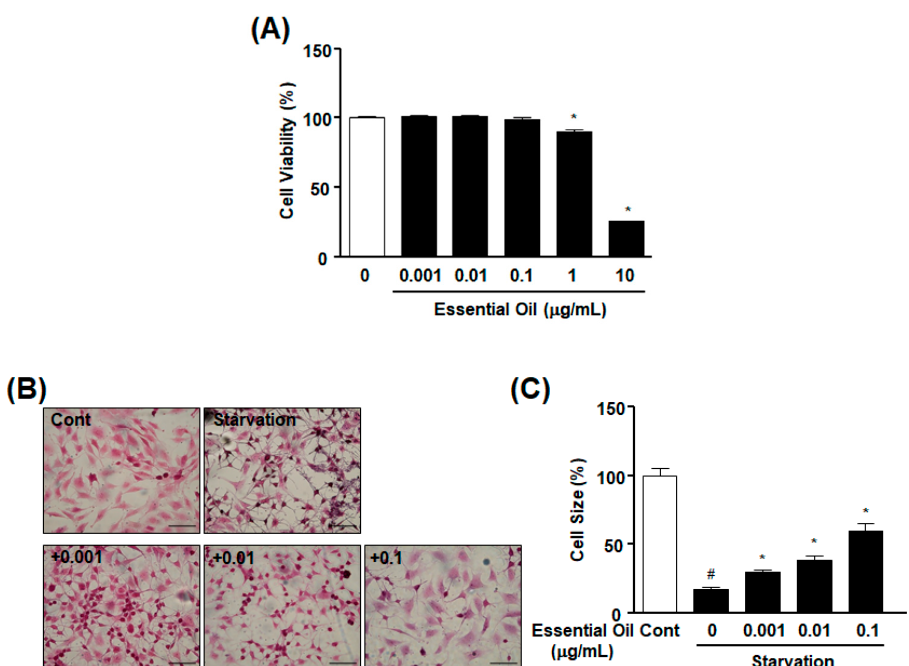
Figure 1. E ff ect of Chrysanthemum boreale Makino essential oil on starvation-induced atrophy of L6 cells. ( A ) E ff ect of Chrysanthemum boreale Makino essential oil (CBMEO) on L6 myoblast viability. Cells were incubated in the presence or absence of essential oil (0.001–10 µ g / mL) for 48 h, and cell viability was measured using an XTT assay. Cellular response in the quiescent state was considered as 100% ( n = 16). * p < 0.05 vs. untreated cells. ( B , C ) E ff ect of CBMEO on starvation-induced atrophy of L6 myoblasts. L6 myoblasts were incubated with serum-free Dulbecco’s modified Eagle’s medium (DMEM) in the presence or absence of essential oil (0.001–0.1 µ g / mL) for 18 h and stained with crystal-violet to measure cell sizes. Cell sizes were measured as described in Materials and Methods. ( B ) Representative images. ( C ) Statistical data obtained from upper panel ( B ). Cell size in the quiescent state was considered as 100% ( n = 9). Scale bar: 100 µ m. * p < 0.05 vs. starved myoblasts in the absence of essential oil. # p < 0.05 vs. the quiescent state Cont, the quiescent state control without starvation.